Question: What form of chart is displayed?
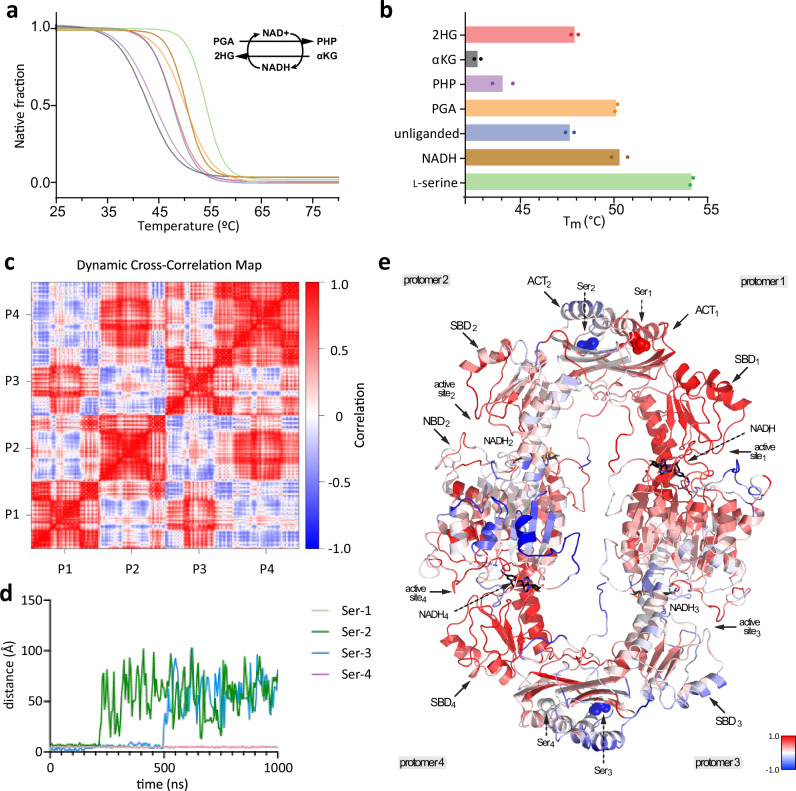
Answer: histogram